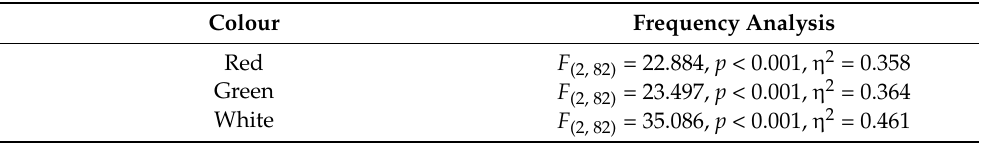
Table 6. Simple effects of the variable Frequency on the SNR of the 1st harmonic in the 3 colors of the